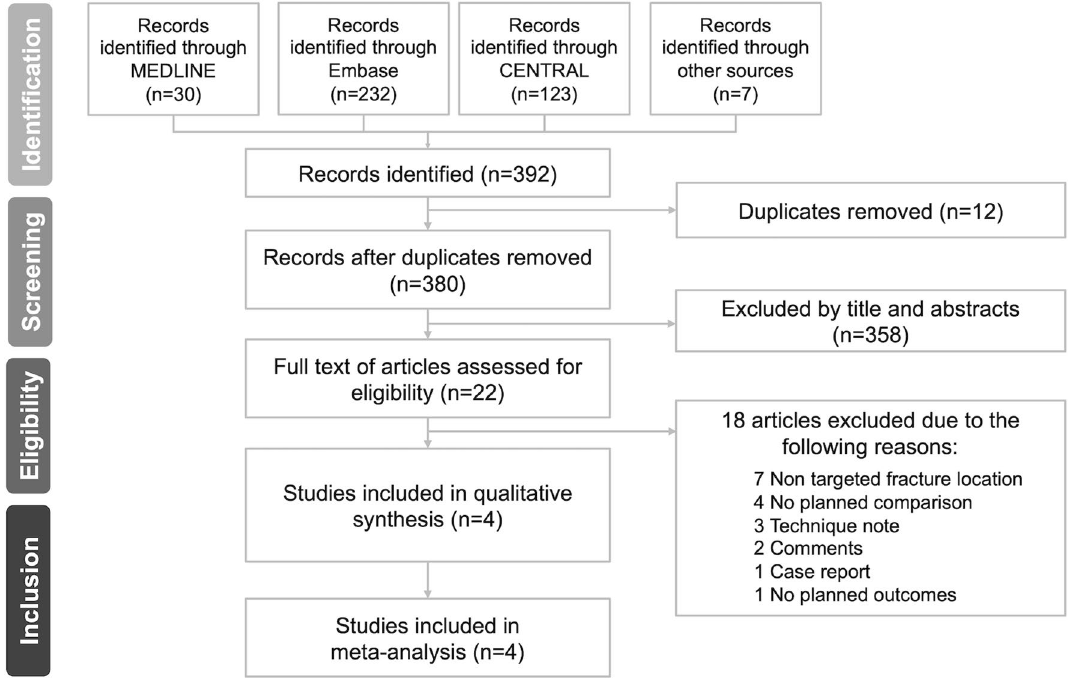
Fig. 1 PRISMA flow diagram of the